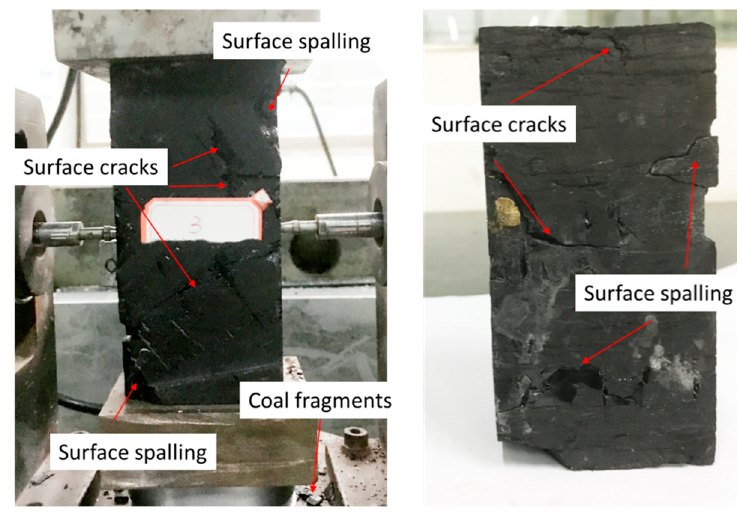
Figure 12. Ultimate failure mode of coal specimens in TJH coal mine.